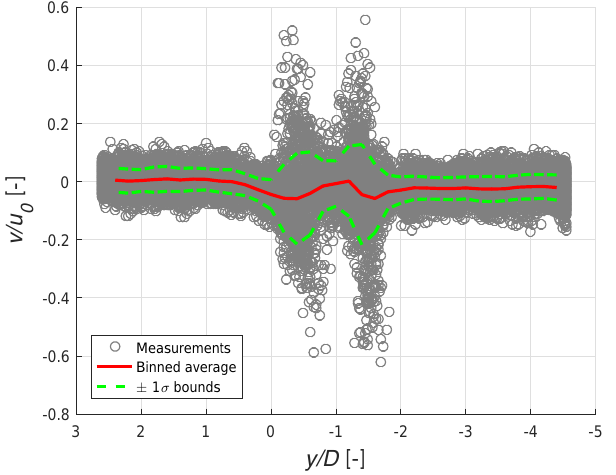
Figure 22. Wake profile expressed in the evaluated v component at 3 D behind the first turbine with a 20 ◦ yaw angle.